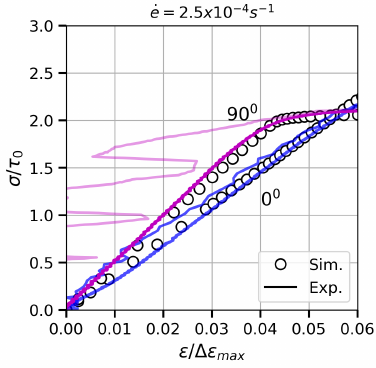
Figure 9. Elastic part of the experimental (coloured lines) and numerical (markers) true stress–strain curves for the quasi-static